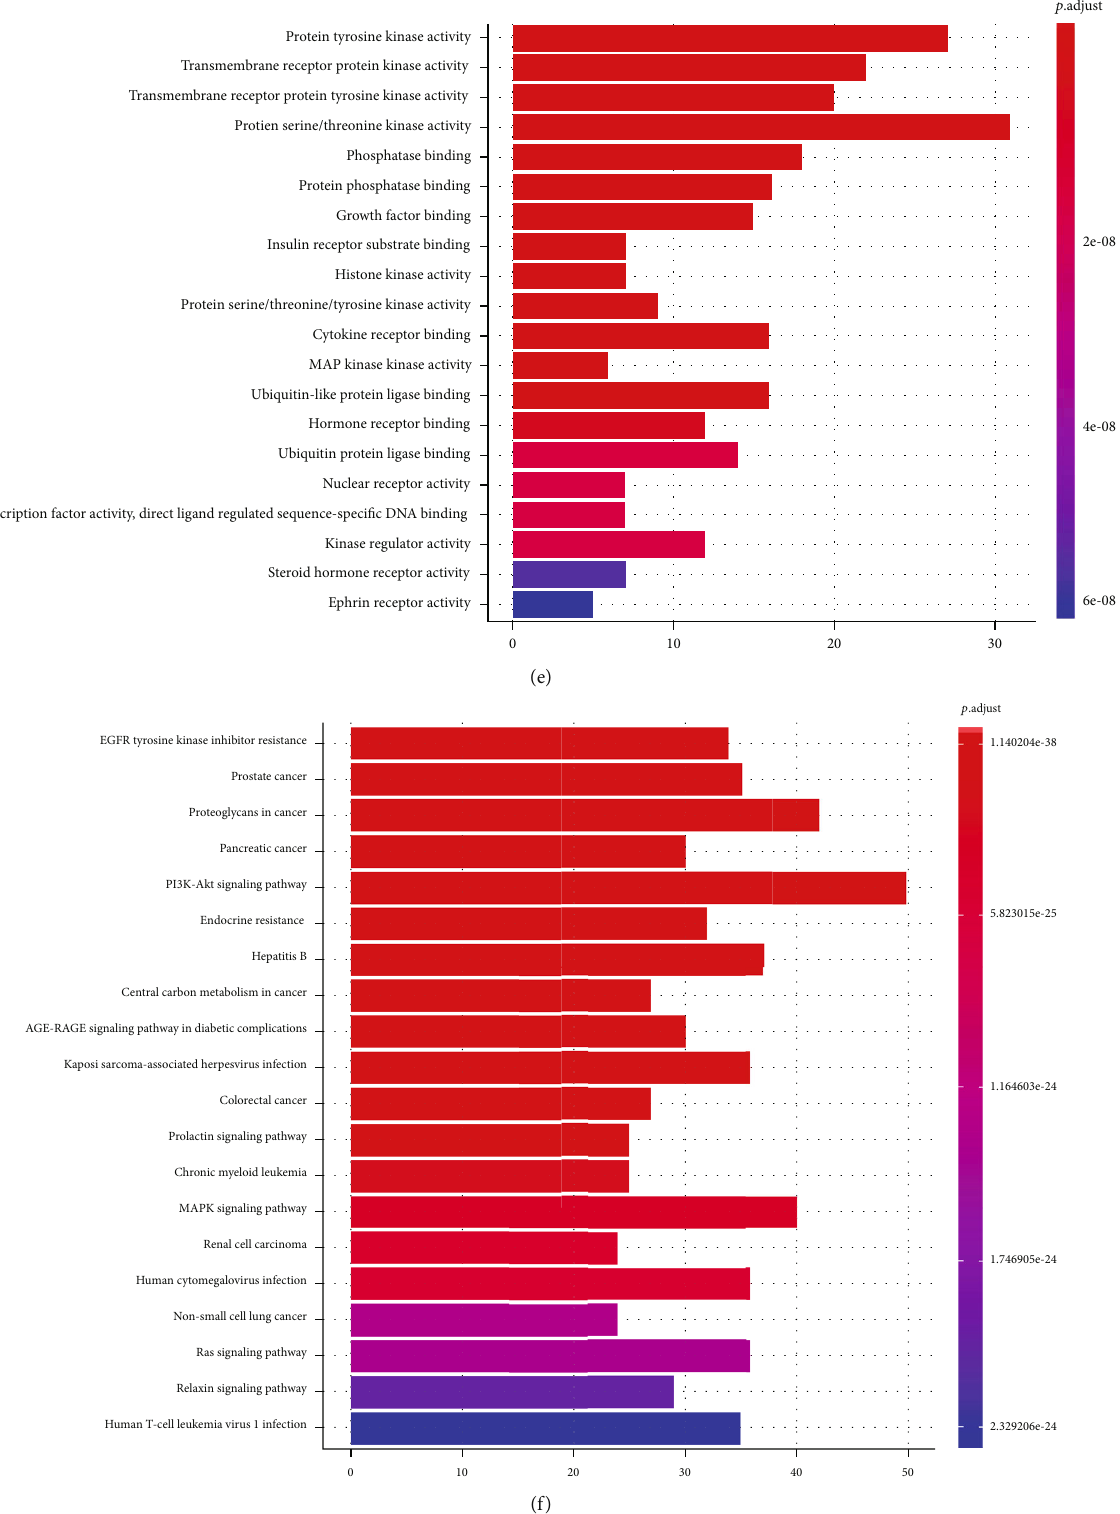
Figure 5: Network pharmacology analysis of the molecular mechanism of Qinghua Jianpi Recipe in preventing the transformation process of in fl ammatory cancer. Network diagram of drug-component-target-disease interactions (a); PPI network of protein interaction (b); the biological processes, cell components, and molecular functions of 137 common targets were selected by GO analysis after R language operation (c – e). The fi rst 20 results formed a bar graph (f) of KEGG functional enrichment, with P value representing the signi fi cance of enrichment, and the redder the color, the higher the signi fi